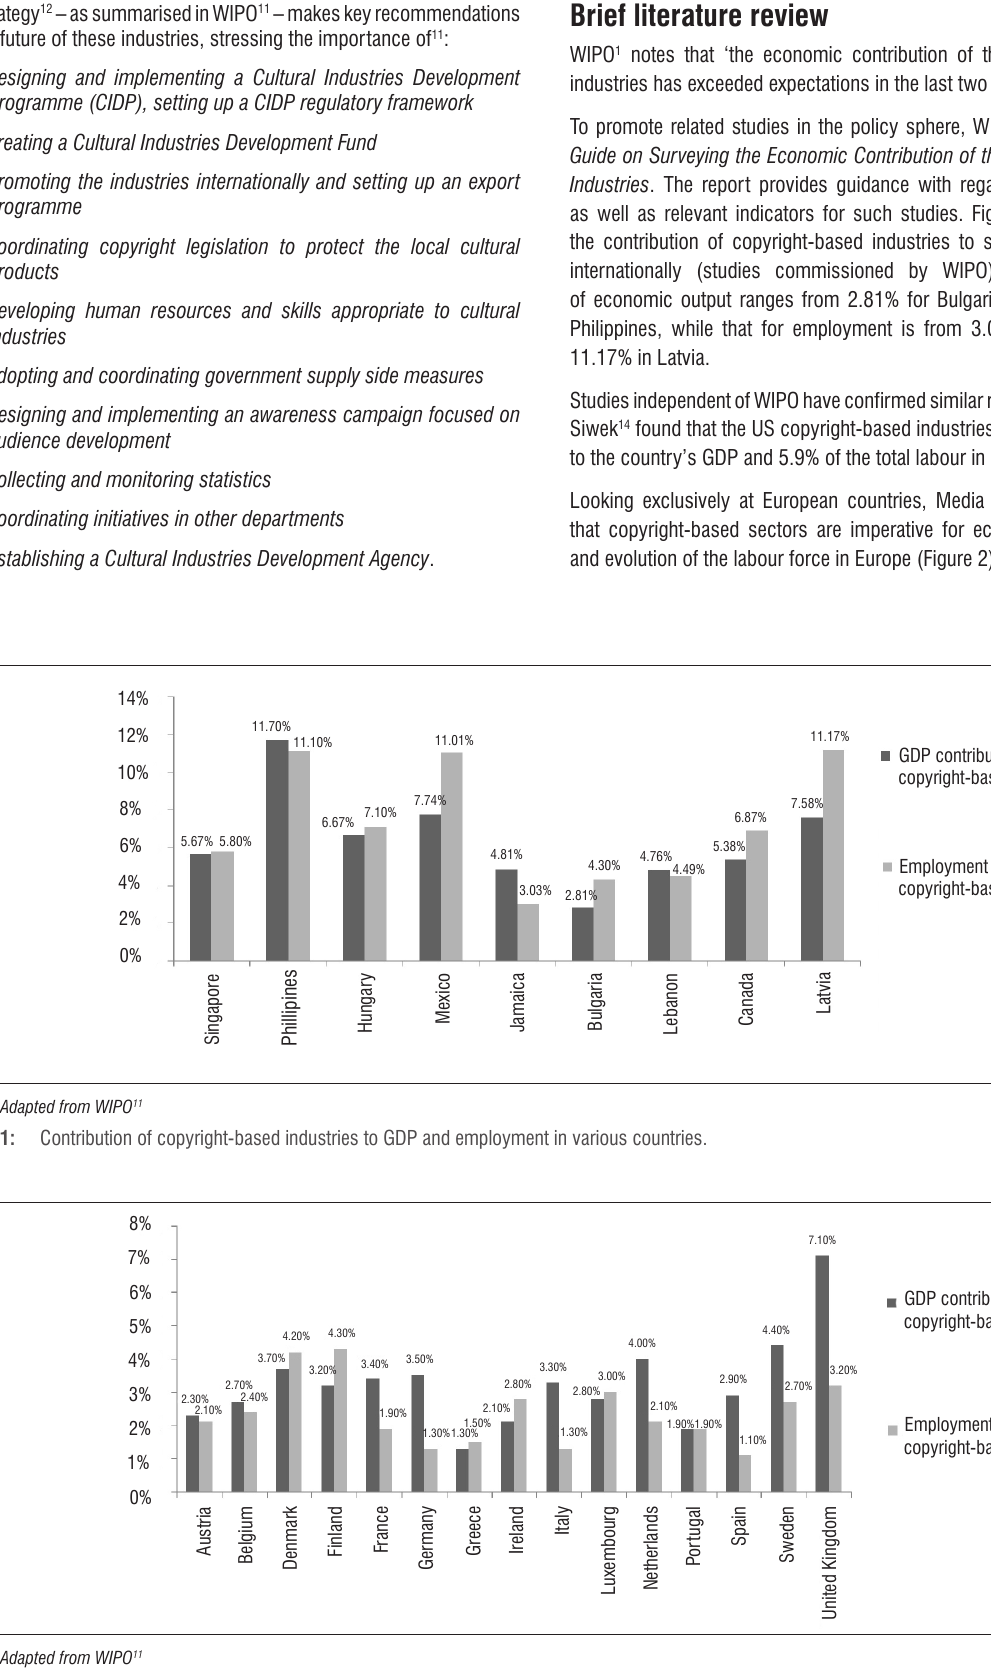
Figure 2: Contribution of copyright-based industries to GDP and employment in countries of the European